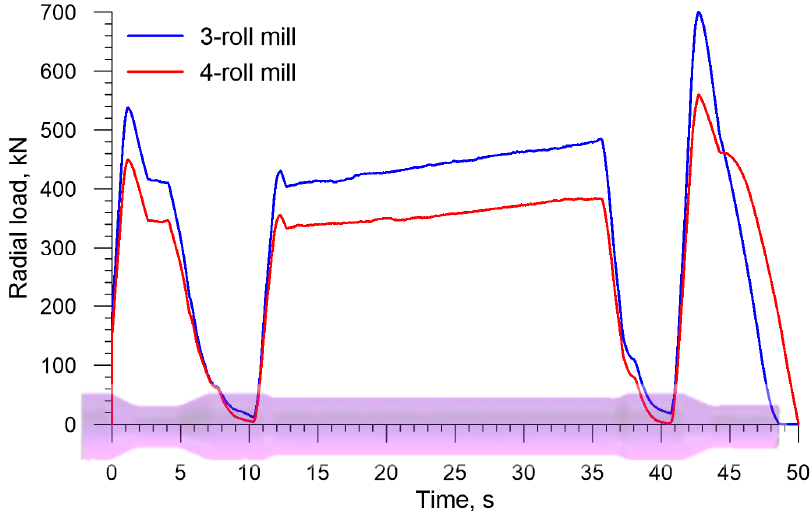
Figure 10. Radial load on the roll in skew rolling railway axles in 3- and 4-roll mills.